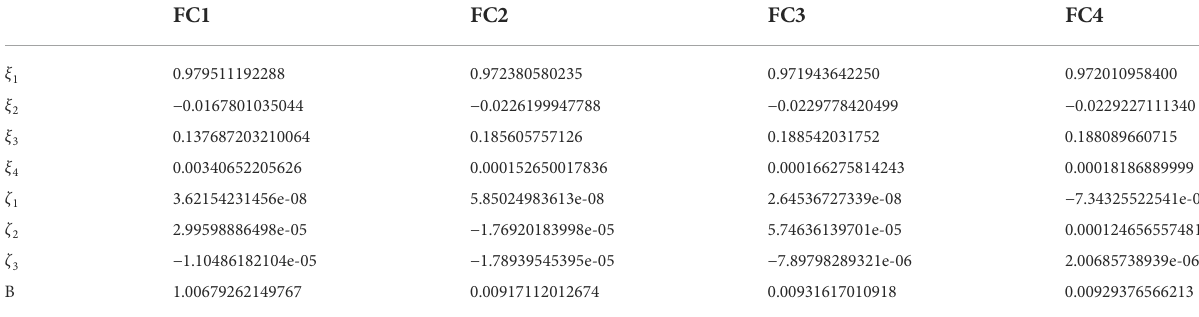
TABLE 1 Parameters for model